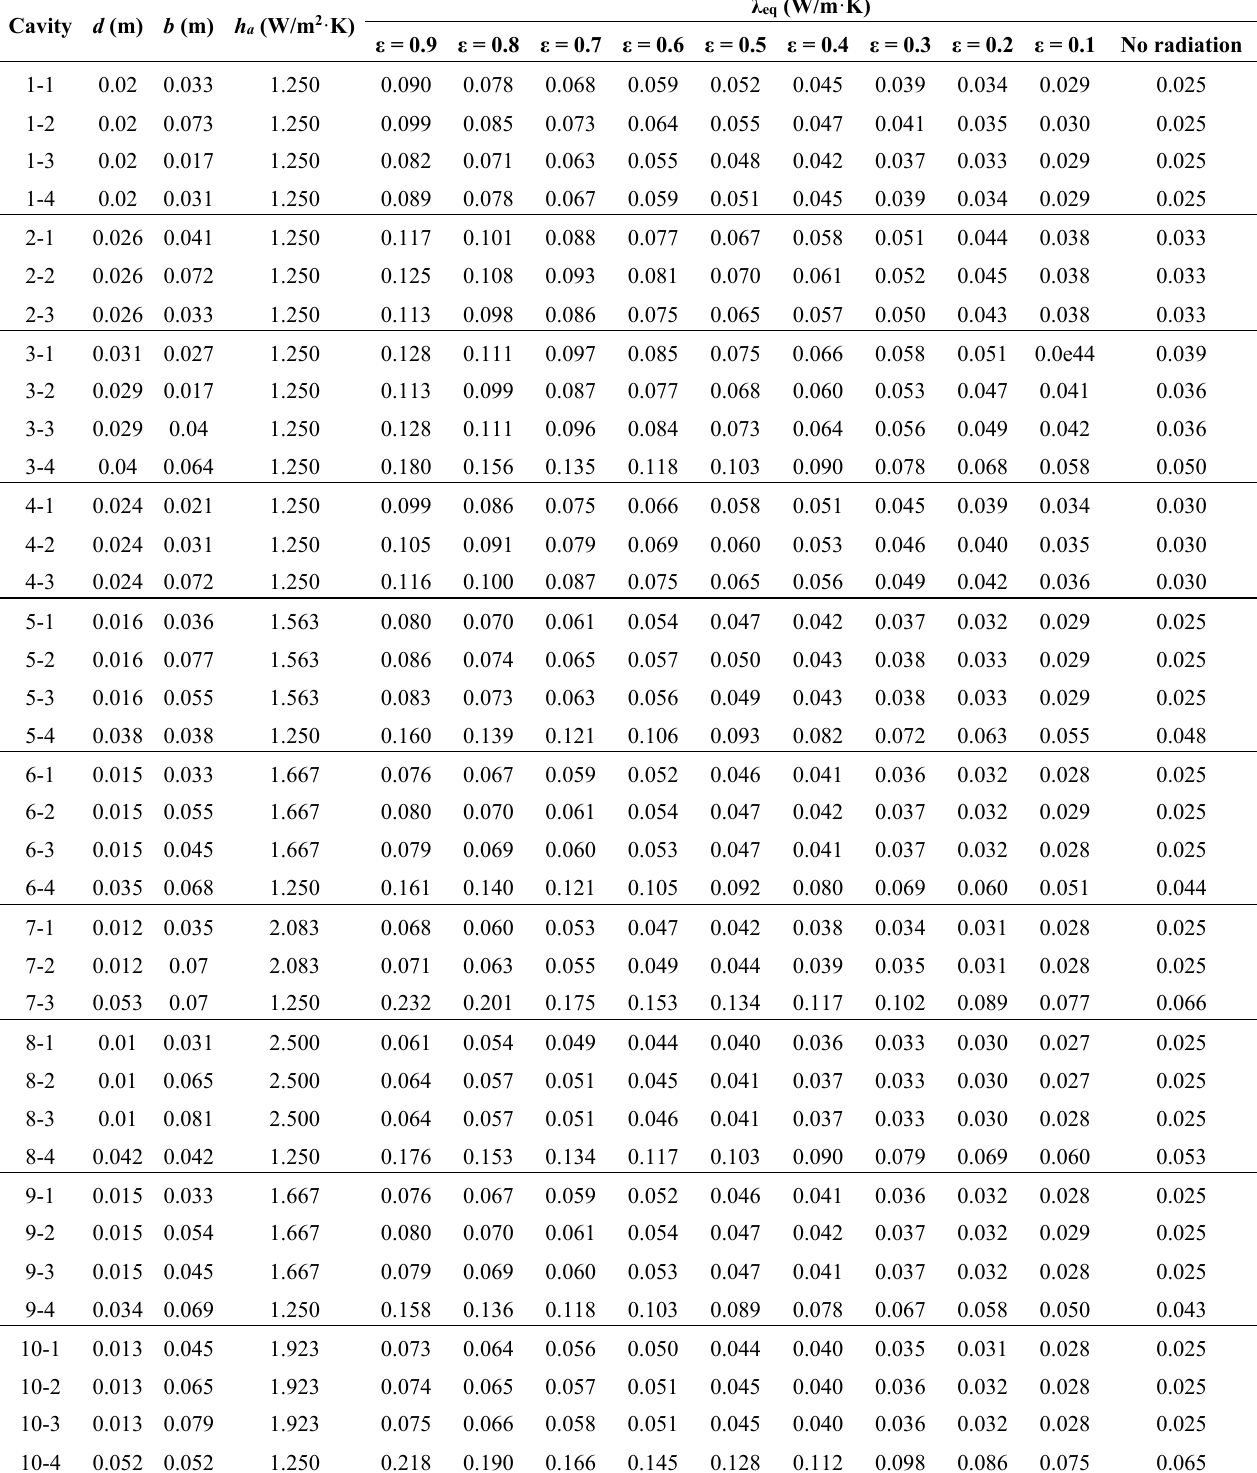
Table 3. Dimensions and equivalent thermal conductivity of the